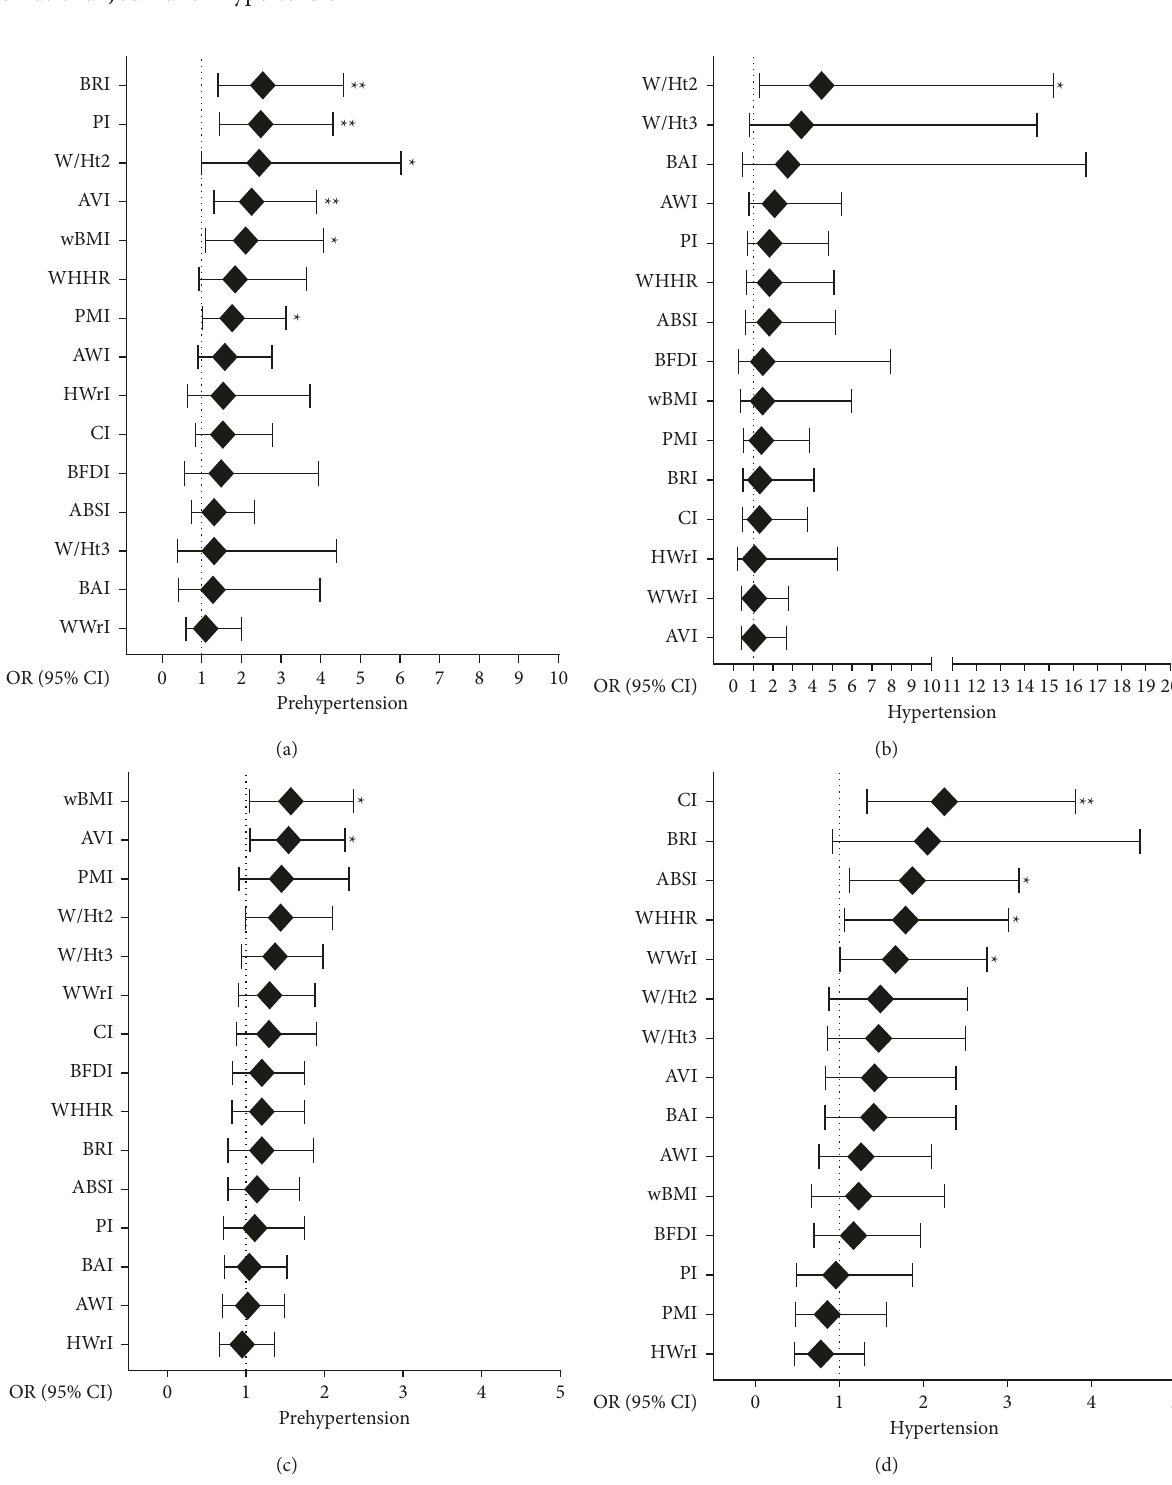
p value p 0.05 and 0 . 01 are ∗ ∗∗ < ≤